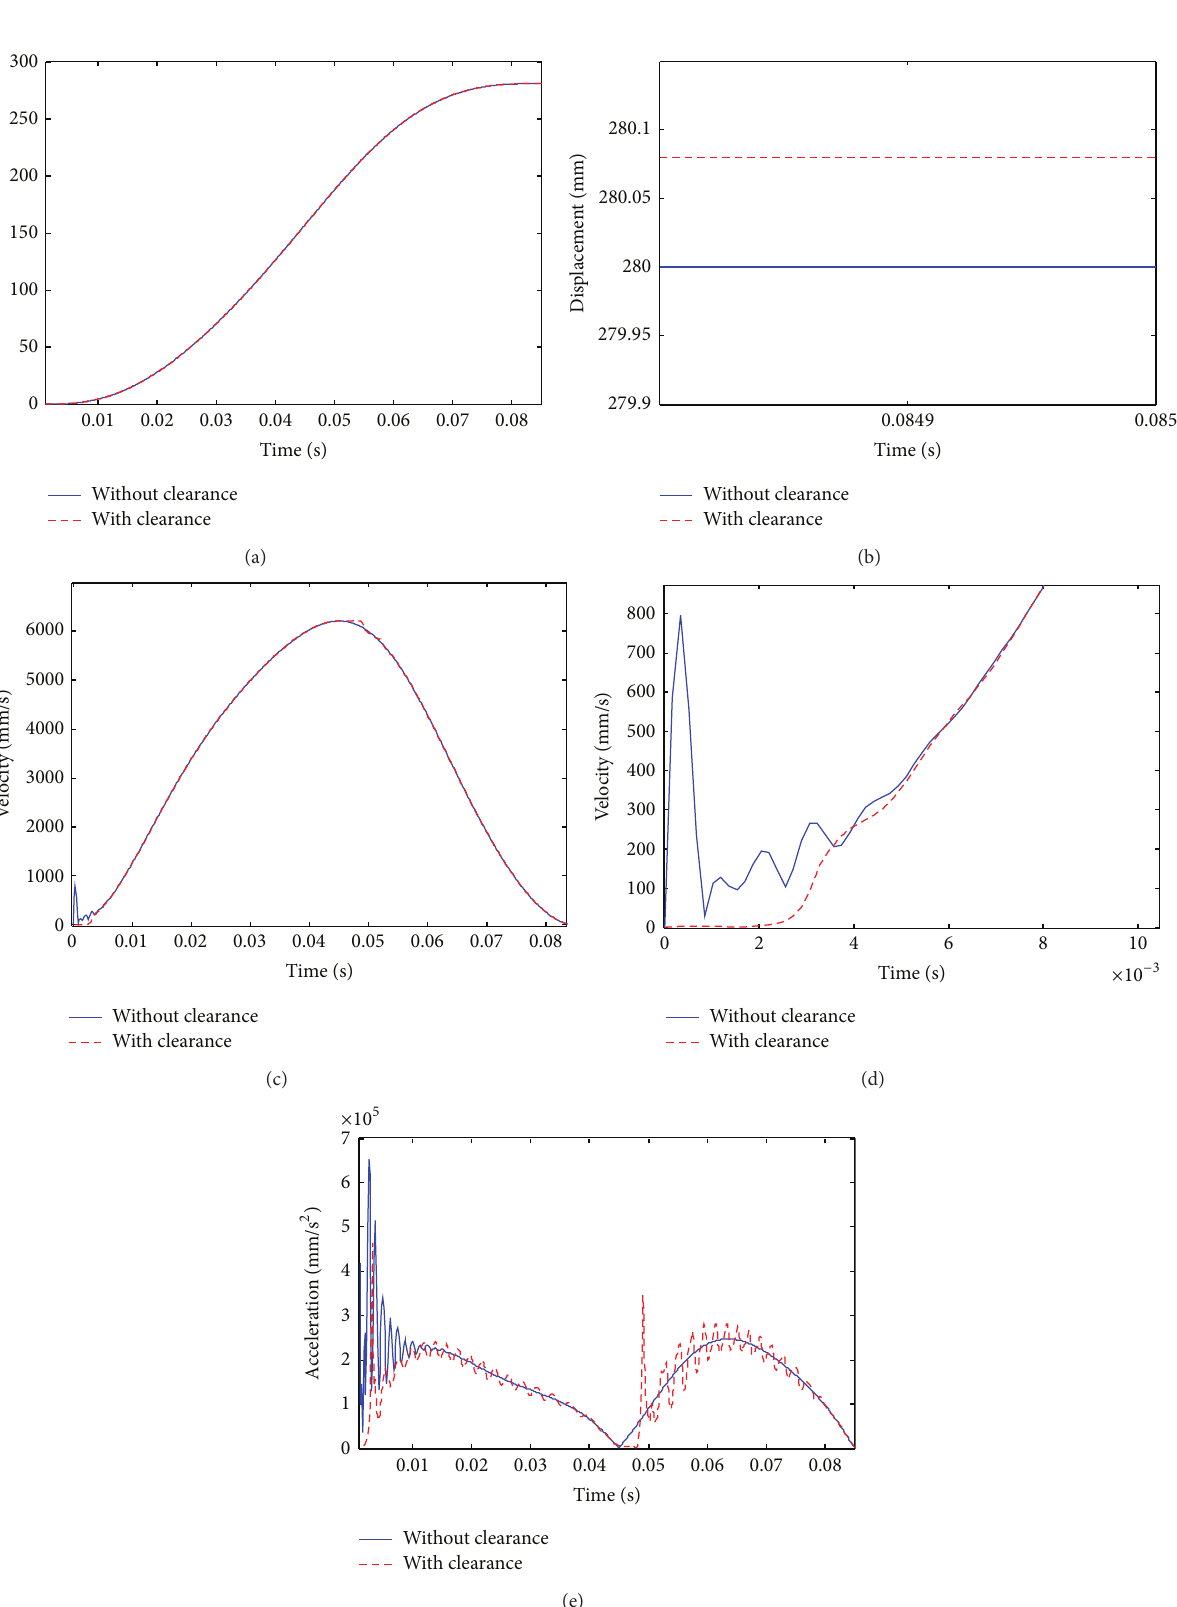
Figure 14: Responses based on the rigid-flexible coupling model with clearance: (a) displacement, (b) enlarged drawing of displacement, (c) velocity, (d) enlarged drawing of velocity, and (e)